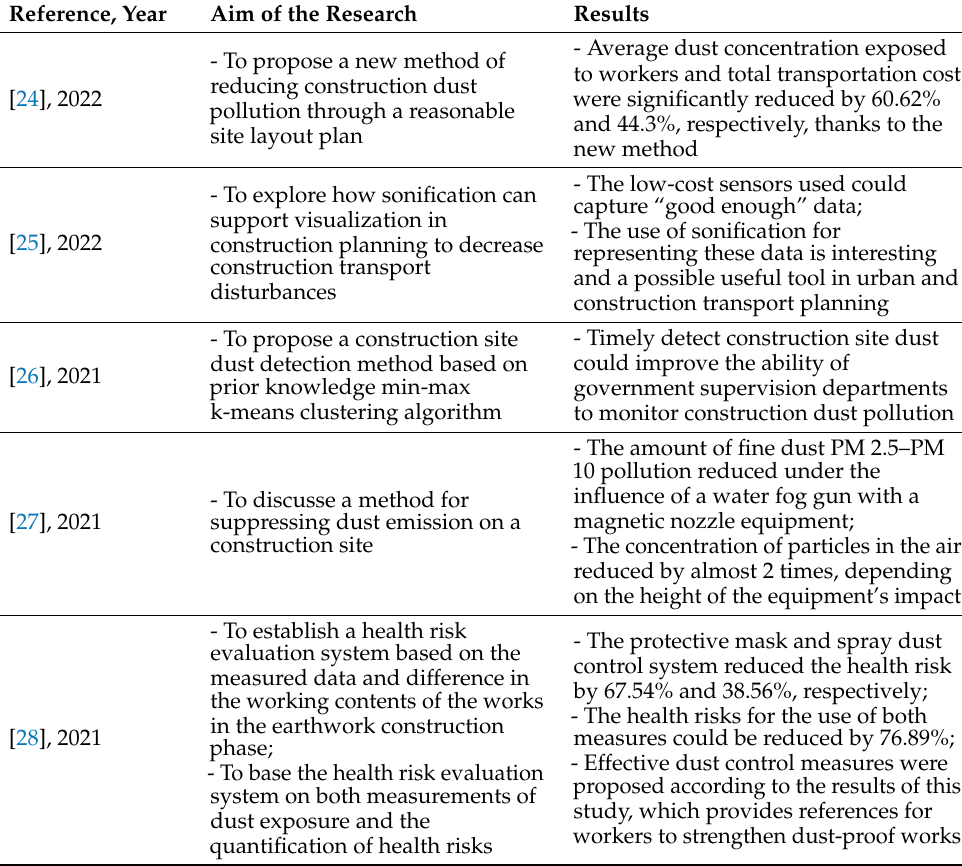
Table 1. Main recent references. In the table, the aim of the research and the results are